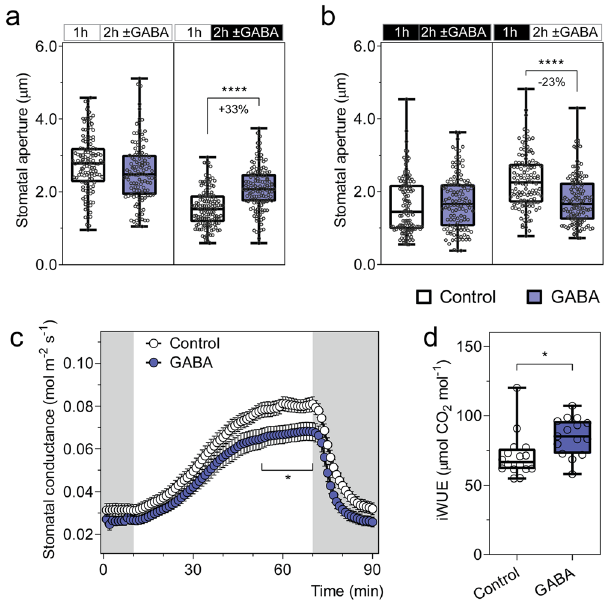
Fig. 2 Exogenous GABA antagonises changes in stomatal pore aperture and increases intrinsic water use ef fi ciency. a , b Stomatal aperture of wild- type A. thaliana leaves in response to light or dark. Epidermal strips were pre-incubated in stomatal pore measurement buffer for 1 h under light ( a ) or dark ( b ), followed by a 2 h incubation under constant light ( a ), dark ( b ), light-to-dark transition ( a ) or dark-to-light transition ( b ) as indicated in the above graphs by the black (dark) or white (light) bars, together with the application of 2 mM GABA; n = 129 for control (constant light), n = 121 for GABA (constant light), n = 137 for control (light-to-dark transition) and n = 135 for GABA (light-to-dark transition) ( a ); n = 122 for control (constant dark), n = 124 for GABA (constant dark), n = 123 for control (dark-to-light transition) and n = 130 for GABA (dark-to-light transition) ( b ); all experiments were repeated twice in steady-state conditions (for both light or dark) or four times for dark-to-light or light-to-dark transitions in different batches of plants using blind treatments with similar results ( a , b ). GABA feeding of excised leaves reduces stomatal conductance ( c ) and increases intrinsic water use ef fi ciency (iWUE) ( d ). c Stomatal conductance of detached leaves from 5- to 6-week-old A. thaliana wild-type plants was recorded using a LI-COR LI-6400XT in response to dark (shaded region) and 200 µ mol m − 2 s − 1 light (white region), fed with arti fi cial xylem sap solutions± 4 mM GABA. d iWUE ef fi ciency of detached leaves was calculated as the ratio of photosynthetic rate (Supplementary Fig. 2b) versus stomatal conductance ( c ); n = 16 independent leaves for control and n = 15 independent leaves for GABA, data collected from three different batches of plants ( c , d ). All data are plotted with box and whiskers plots: whiskers plot represents minimum and maximum values, and box plot represents second quartile, median and third quartile ( a , b , d ), or data are represented as mean± s.e.m ( c ); statistical difference was determined by two-way ANOVA ( a , b ), or two-sided Student ’ s t test ( c , d ), * P < 0.05 and **** P < 0.0001. muscimol, then removing this treatment and performing a light or dark transition. As would be expected from viable cells, after removal of the GABA or muscimol treatment, we found that stomatal guard cells responded to a light treatment by opening the pores (Supplementary Fig. 4a, b) or to a dark treatment by closing pores (Supplementary Fig. 4c, d). Collectively, these data again indicate that GABA signals would likely act to modulate stomatal aperture in the face of a stimulus rather than stimulating a transition itself.